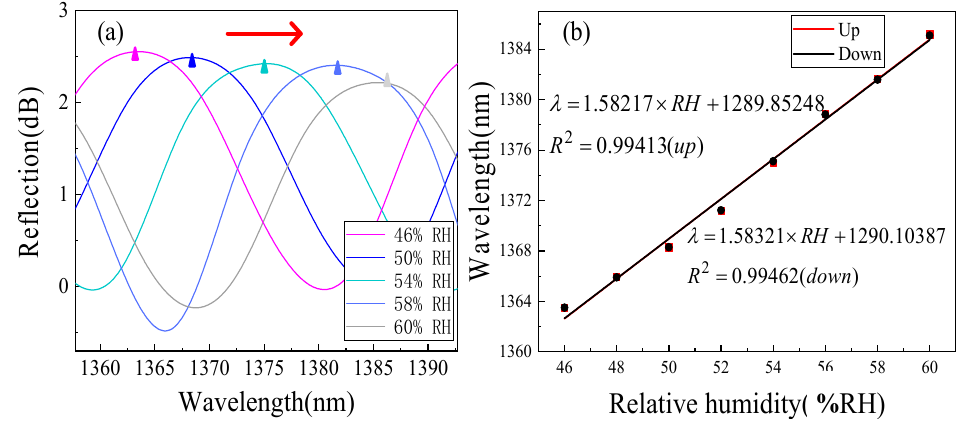
Figure 9. RH response results of the upper envelope. ( a ) Reflection spectra of the sensor at 46–60%RH and ( b ) measured wavelength shift vs. RH rising and falling.